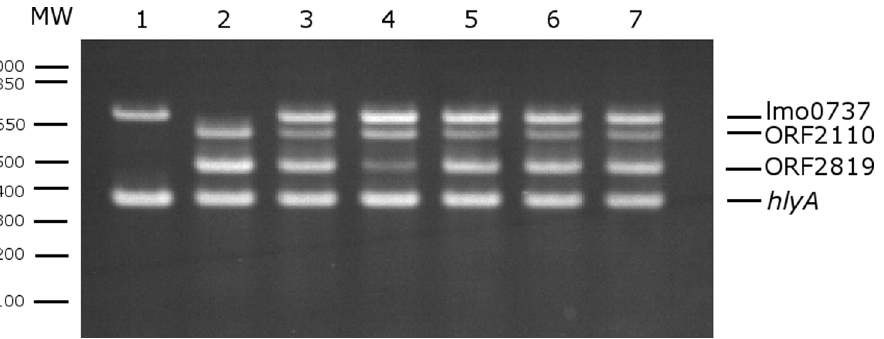
Figure 1. Multiplex PCR profiles of L.monocytogenes strains. Lanes: MW, Molecular weight markers. Lane 1: LS1 serotype 1/2a, Lane 2: LS402, serotype 4b; Lane3-7: serotype IVb-v1 strains LS542; LS642; LS643; LS644; LS645, respectively.